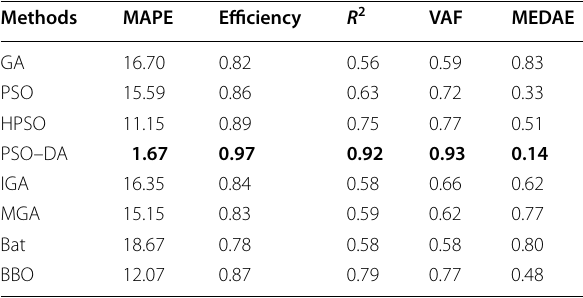
Table 7 Results for the test dataset.